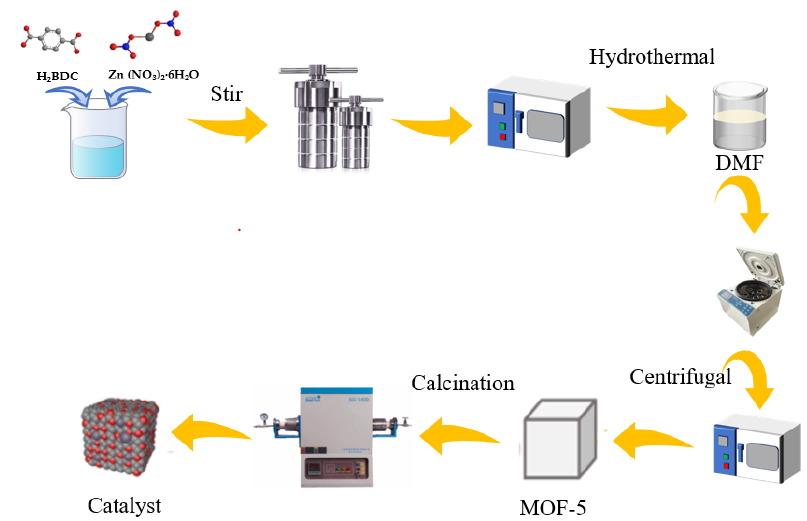
Figure 17. Catalyst preparation flow chart .